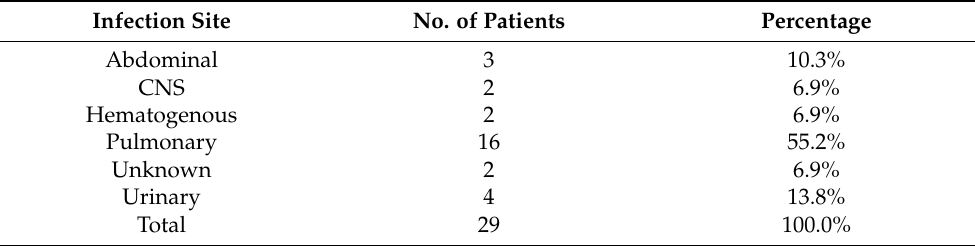
Table 1. Distribution of the study group according to the infection site.